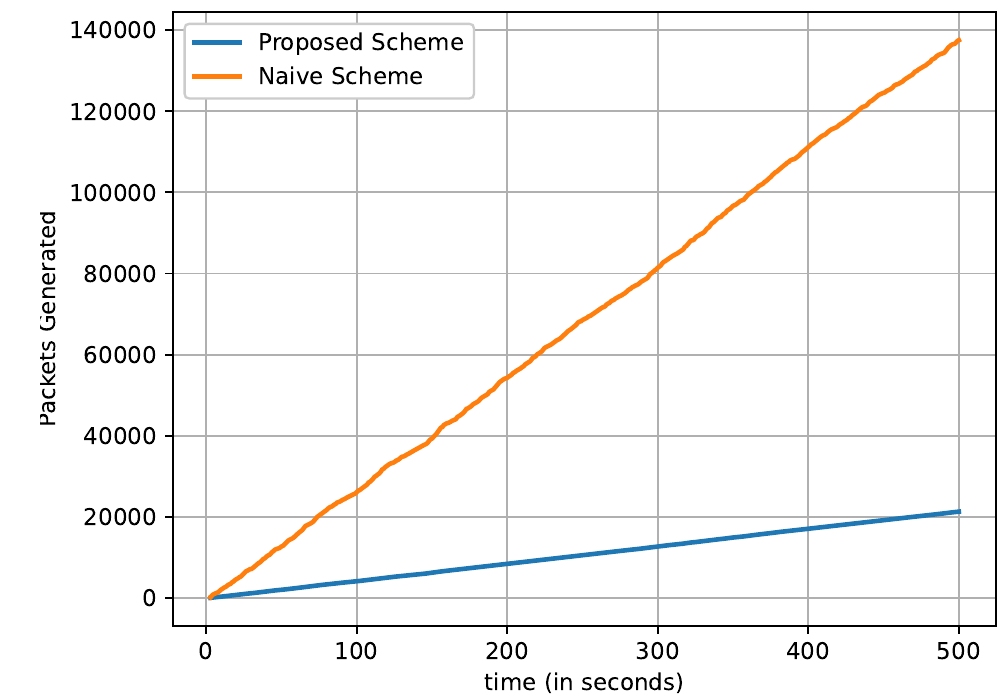
Figure 9. Total number of data packets broadcast with respect to the vehicle density; i.e., ( λ = 20).